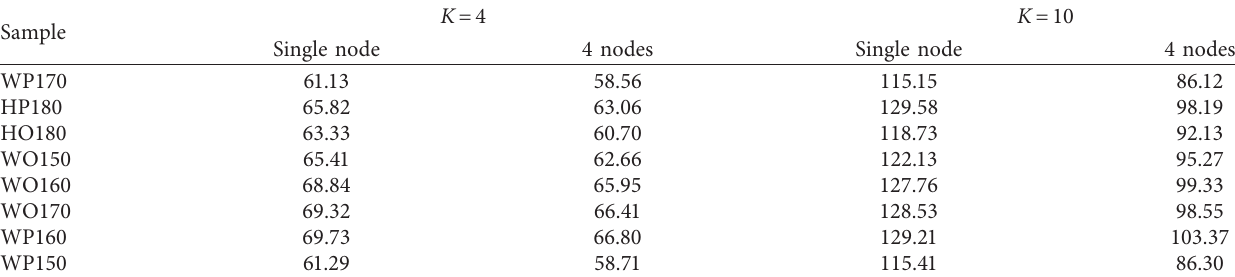
Table 11: Single node v/s multiple Hadoop nodes execution time (sec) for 1FT condition.